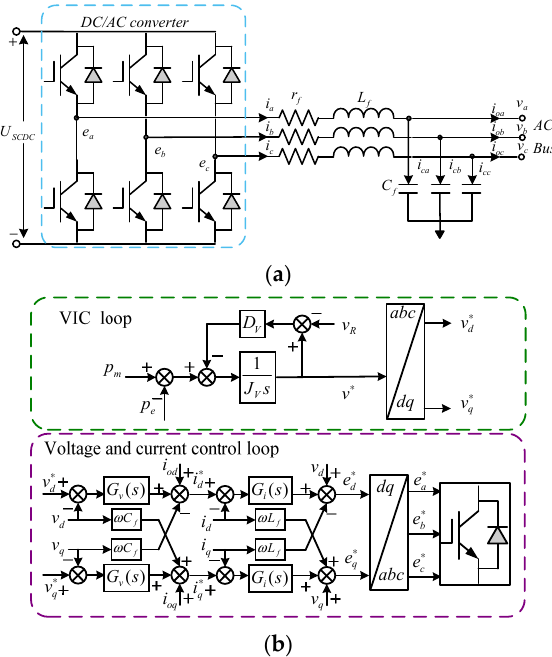
Figure 4. Structure and VIC block diagram of the SC converter. ( a ) Structure of the SC converter; ( b ) VIC block diagram of the SC converter.